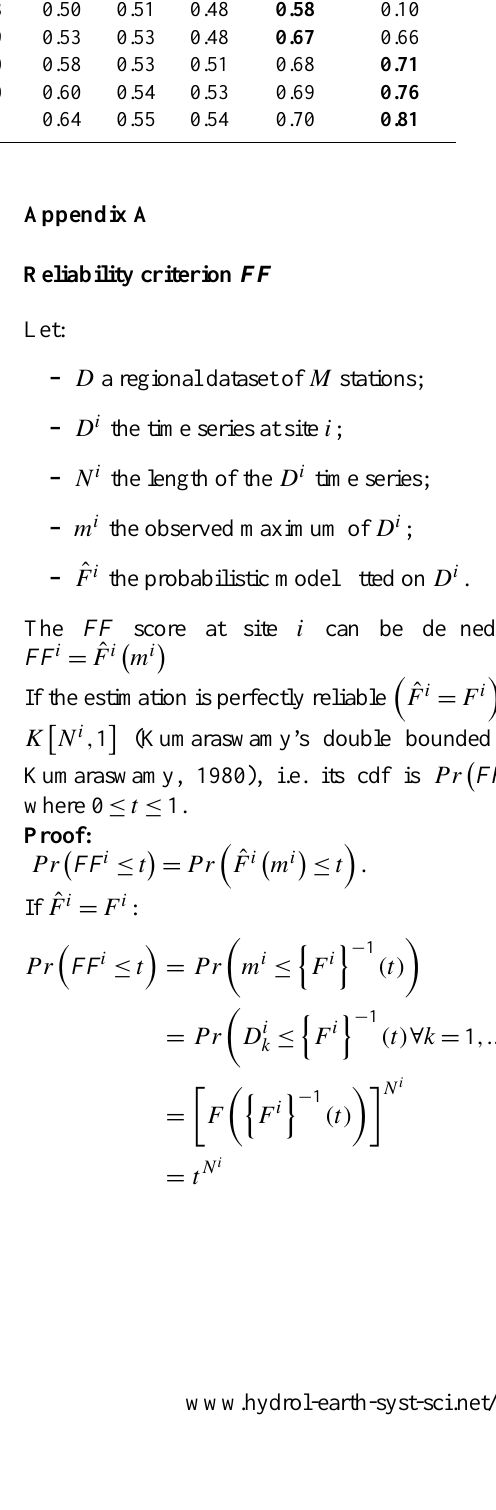
Table 4. Mean SPAN T and COVER T criteria (the numbers in bold highlight the best performance for each return period). Score Return period Ideal score GUM GEV EXP GPD MEWP MGPWP (year) 10 0 0.09 SPAN T